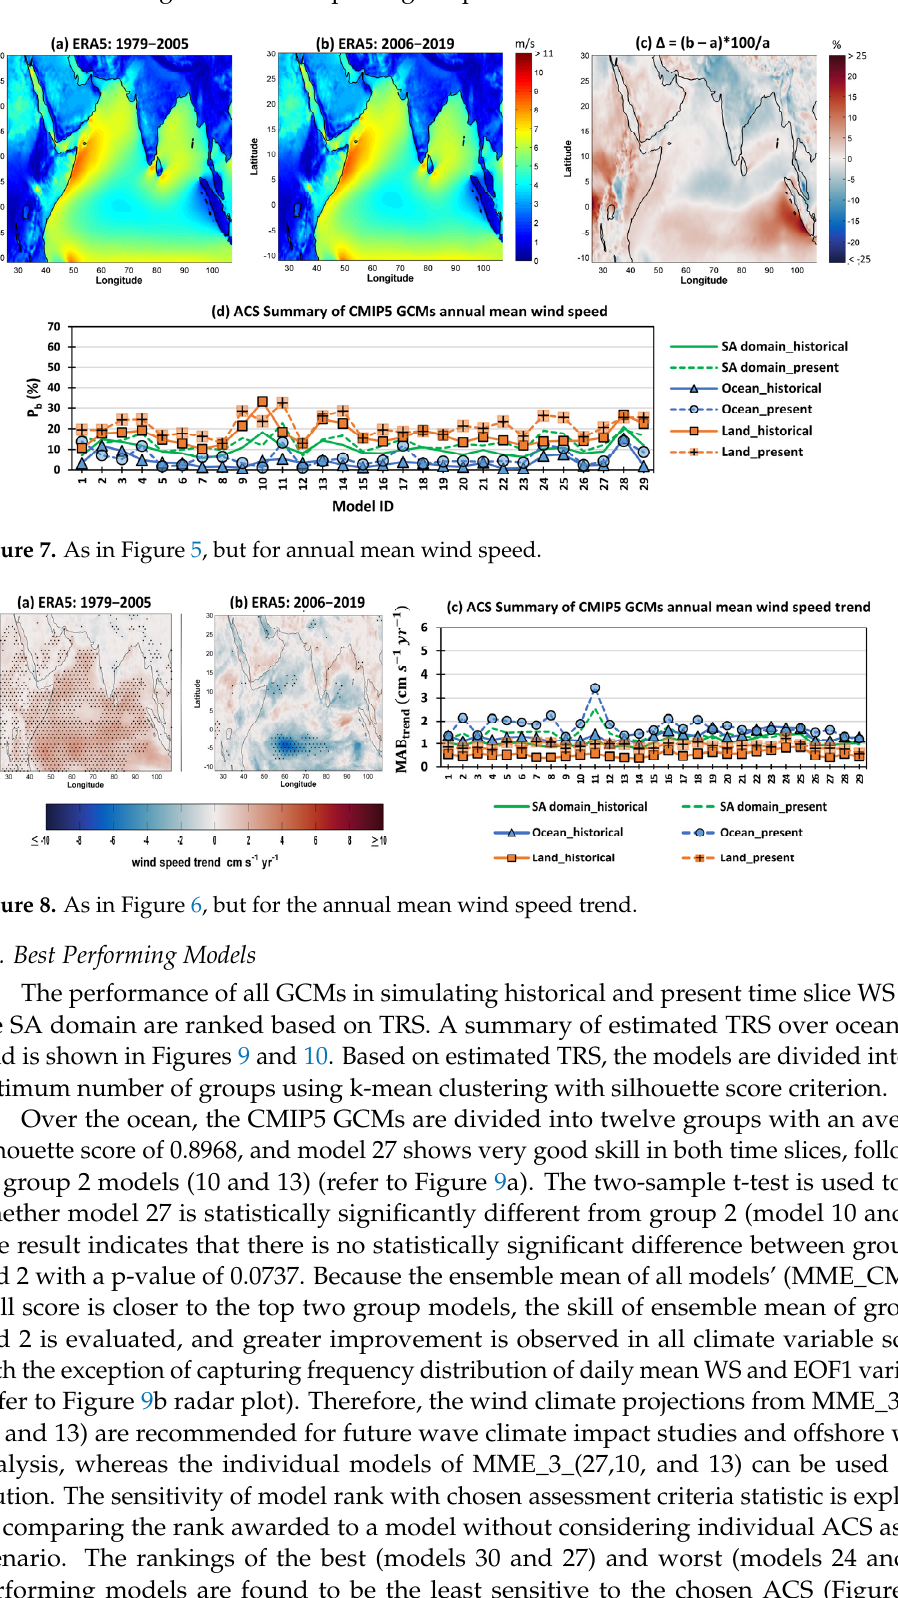
Figure 7. As in Figure 5, but for annual mean wind speed.